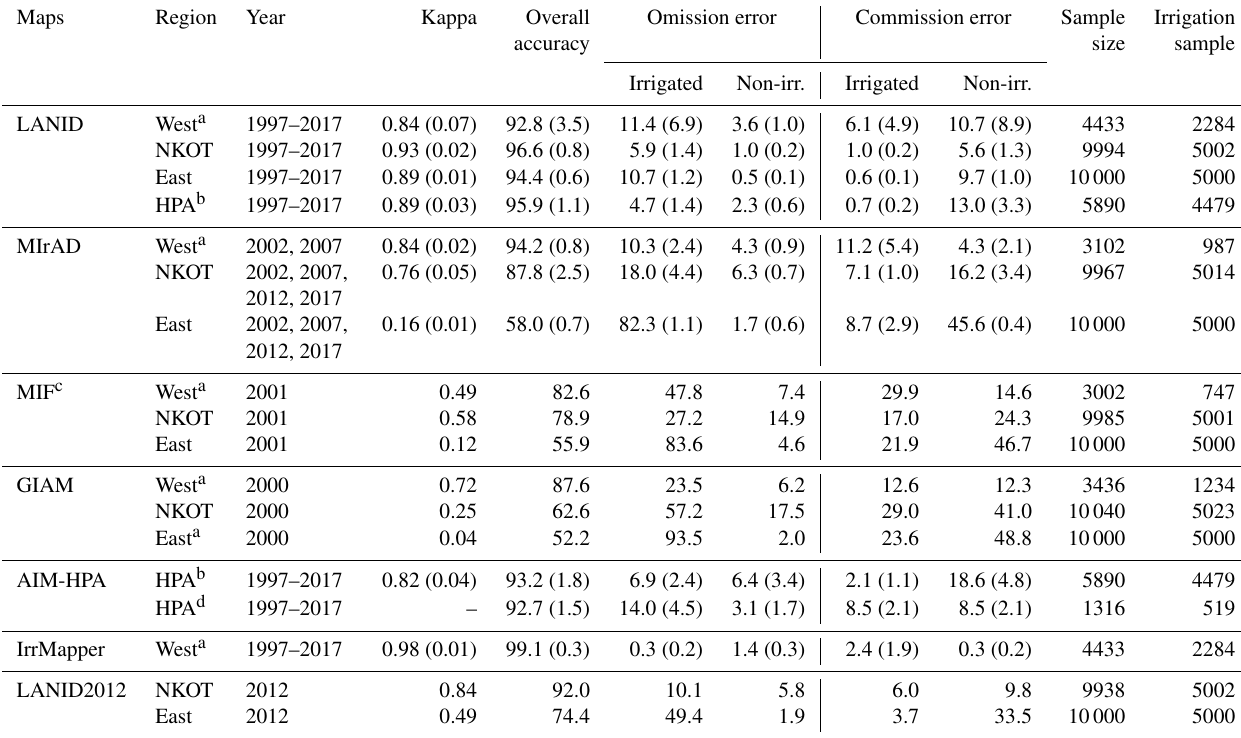
Table 4. Confusion table of pixel-wise accuracy assessment. The overall accuracy, omission error (1 – producer’s accuracy), and commission error (1 – user’s accuracy) are in percent. Accuracy values are averaged if multiple-year assessment was conducted. Parenthetical numbers represent the standard